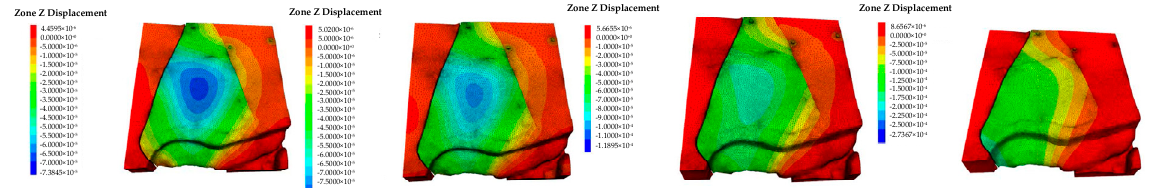
Figure 17. Vertical displacement clouds of the top slab of the damage factor of different broken slates.